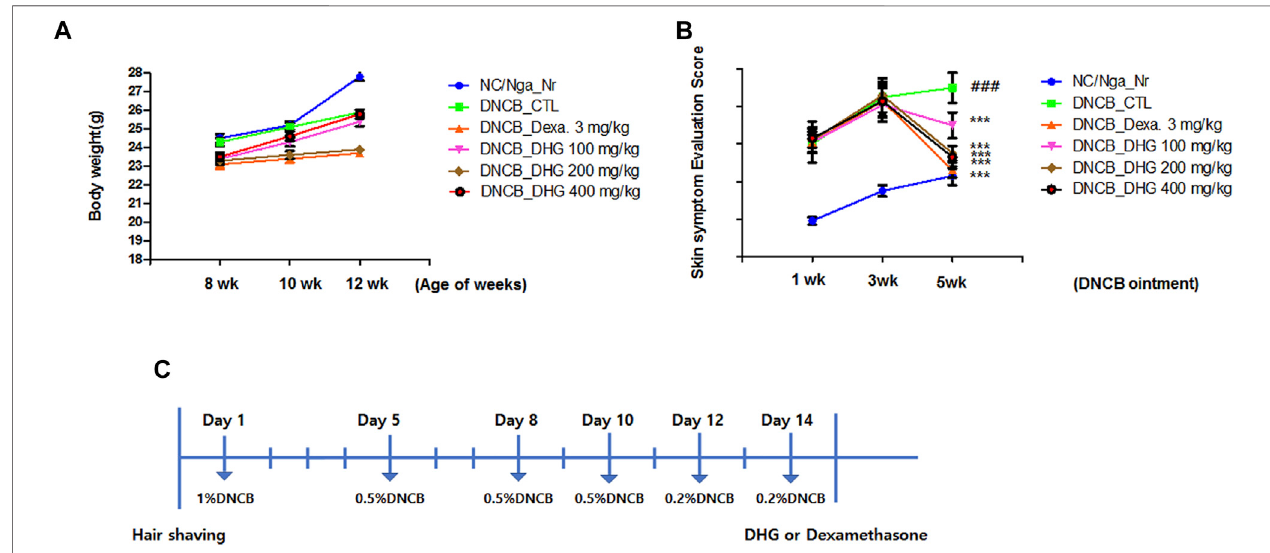
FIGURE 1 | Changes in body weight (A) and skin features and severity (B) in NC/Nga mice (total n = 6/group). Schematic diagram of the experimental protocol in NC/Nga mice (C) .